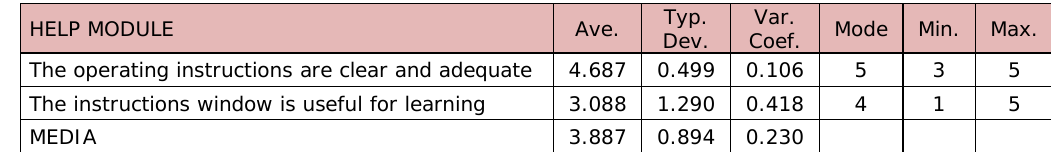
Table 6. “Assessment of Help